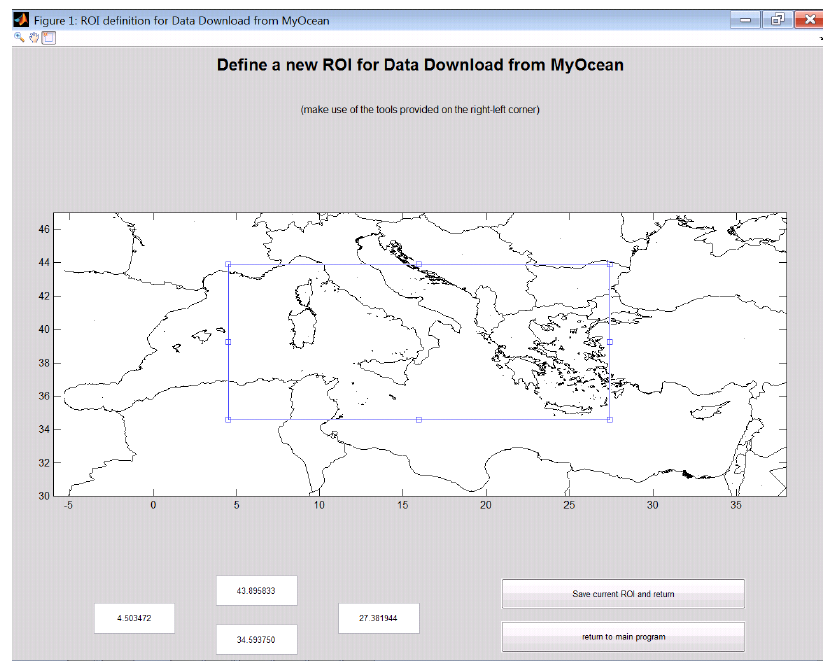
Figure 1. The Region Of Interest (ROI) definition